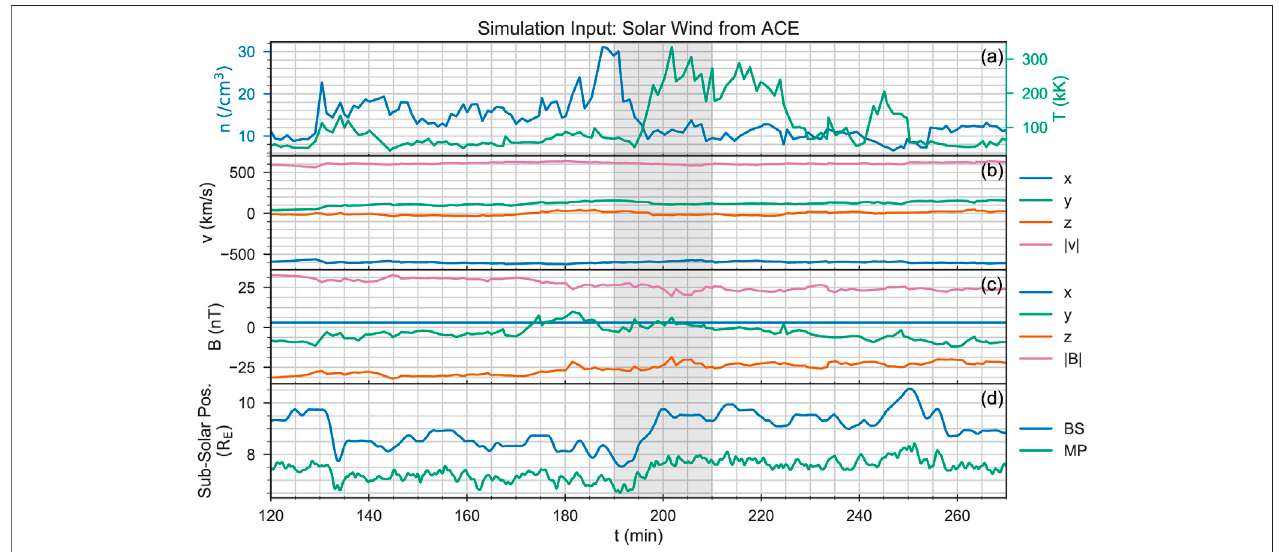
FIGURE 1 | The solar wind input to the simulation, and the position of the bow shock and magnetopause in response. The shaded region denotes the region of interest during this chapter.